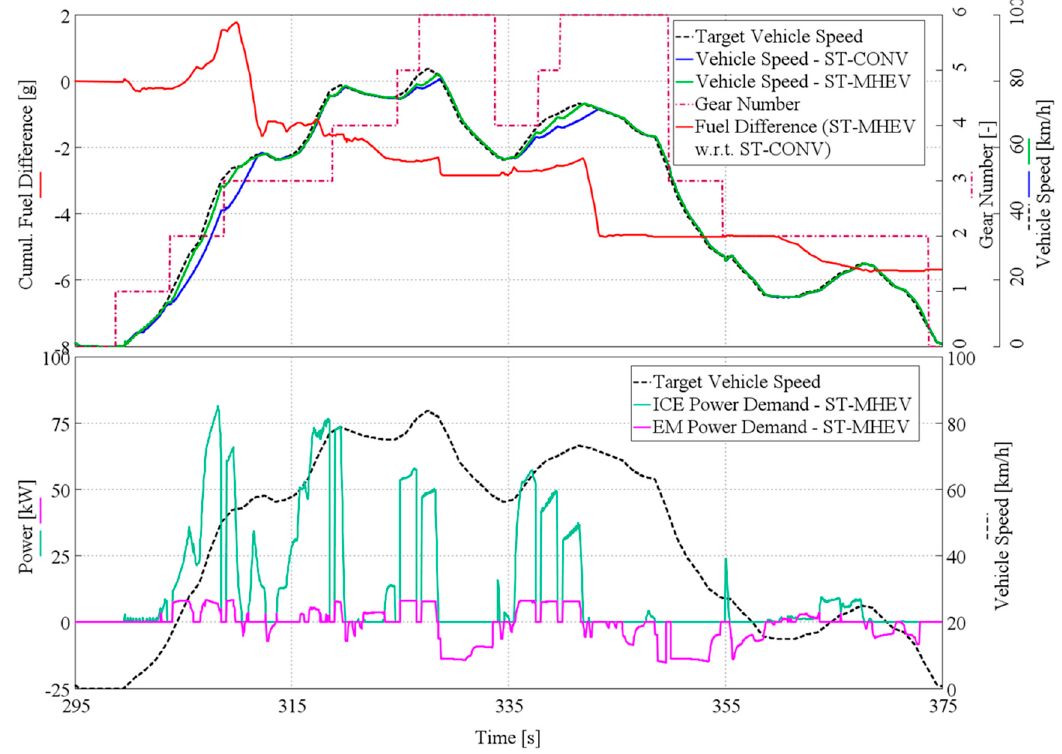
Figure 11. Detail of the hybrid control strategy operation in the RTS-95 driving cycle (from 295 s to 375 s): vehicle speed, gear number and cumulated fuel consumption difference on top chart; powersplit optimization in the bottom chart. Table 8. Recovered energy on the NEDC, WLTC and RTS-95 for the ST-MHEV and the HE-MHEV powertrain